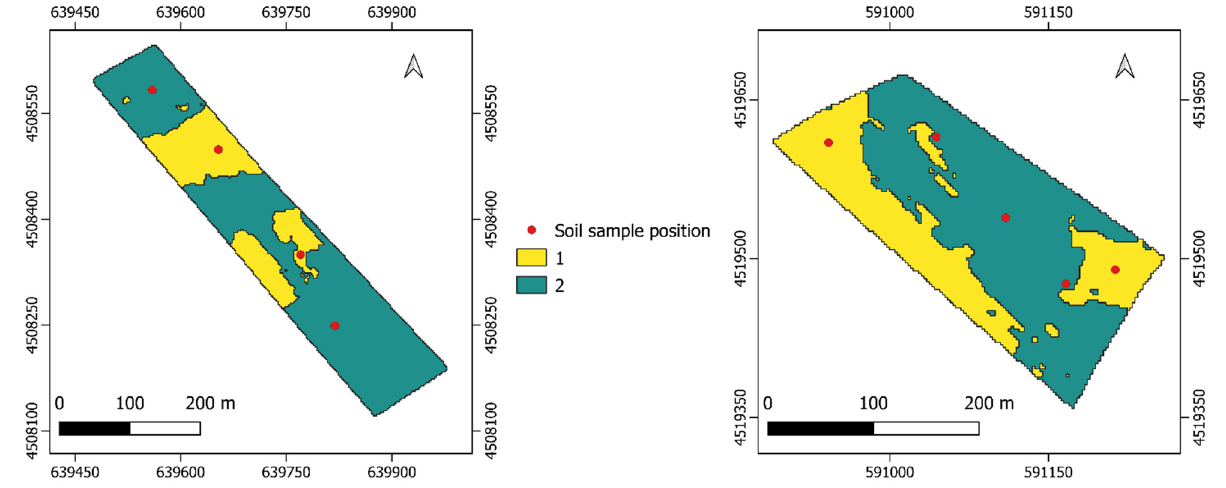
Figure 4. Zone management maps for both sites and relative soil samples position. Table 6. Results of the ANOVA applied to the soil samples based on the zone management experi- mental factor for both sites.